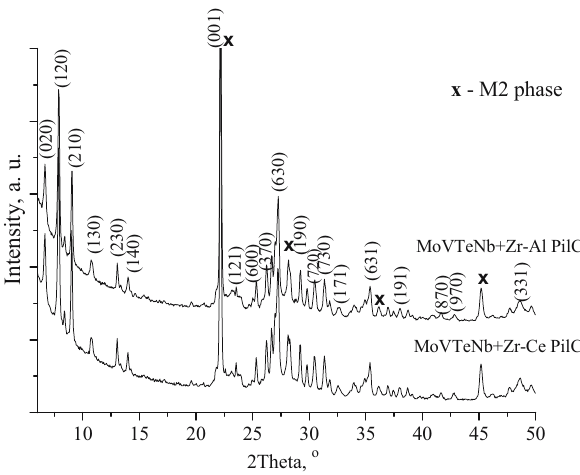
Figure 3: Di ff raction patterns of bulk VMoTeNbO and its composites with 10 wt% of Zr – Ce - or Zr – Al - pillared clays after catalytic tests.